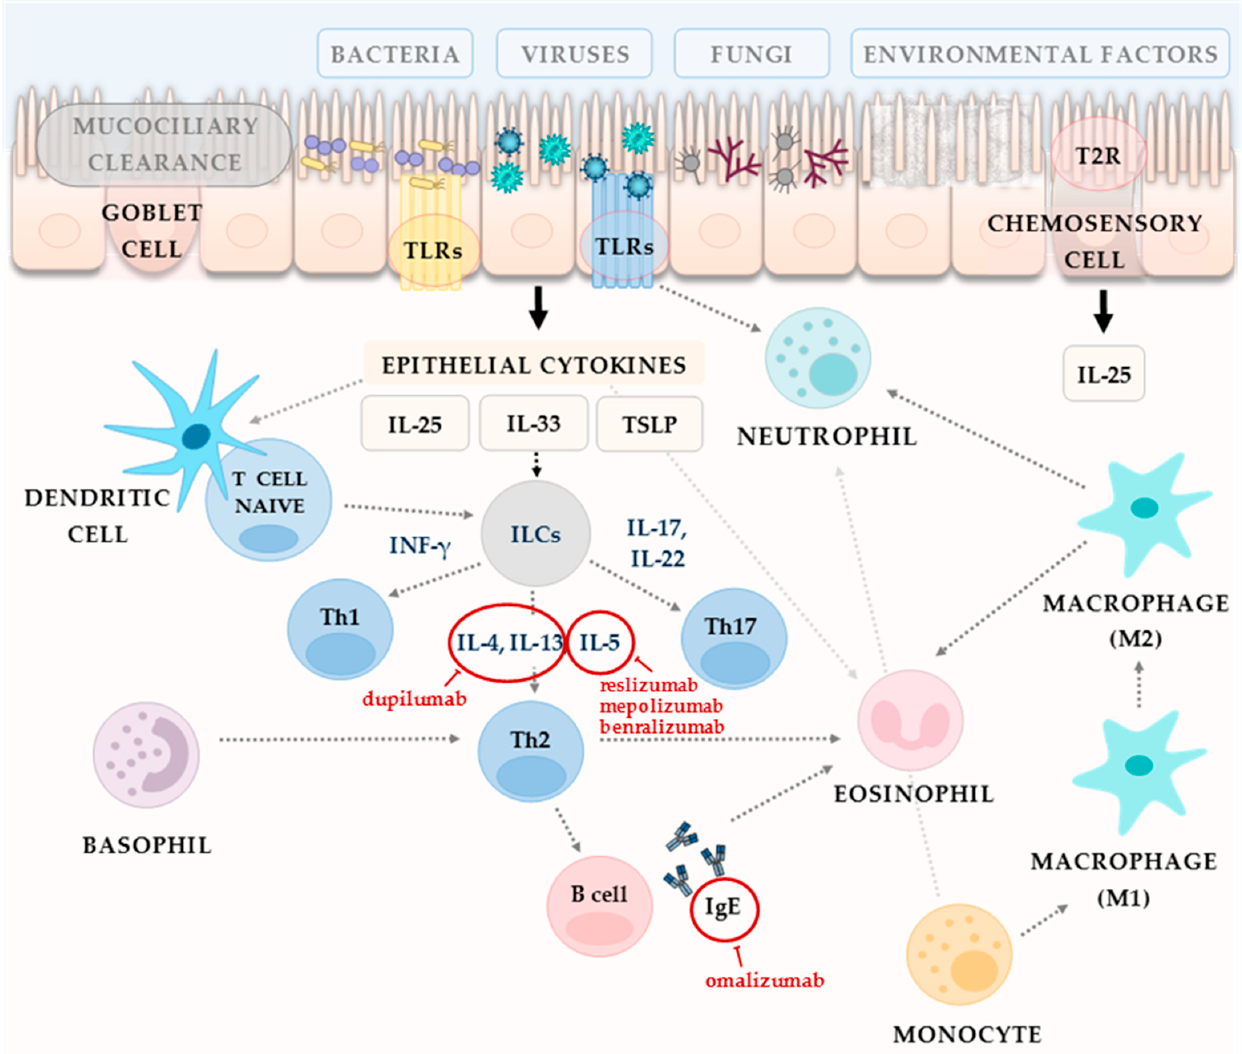
Figure 3. General immune mechanism involved in the pathogenesis of CRS and targets for